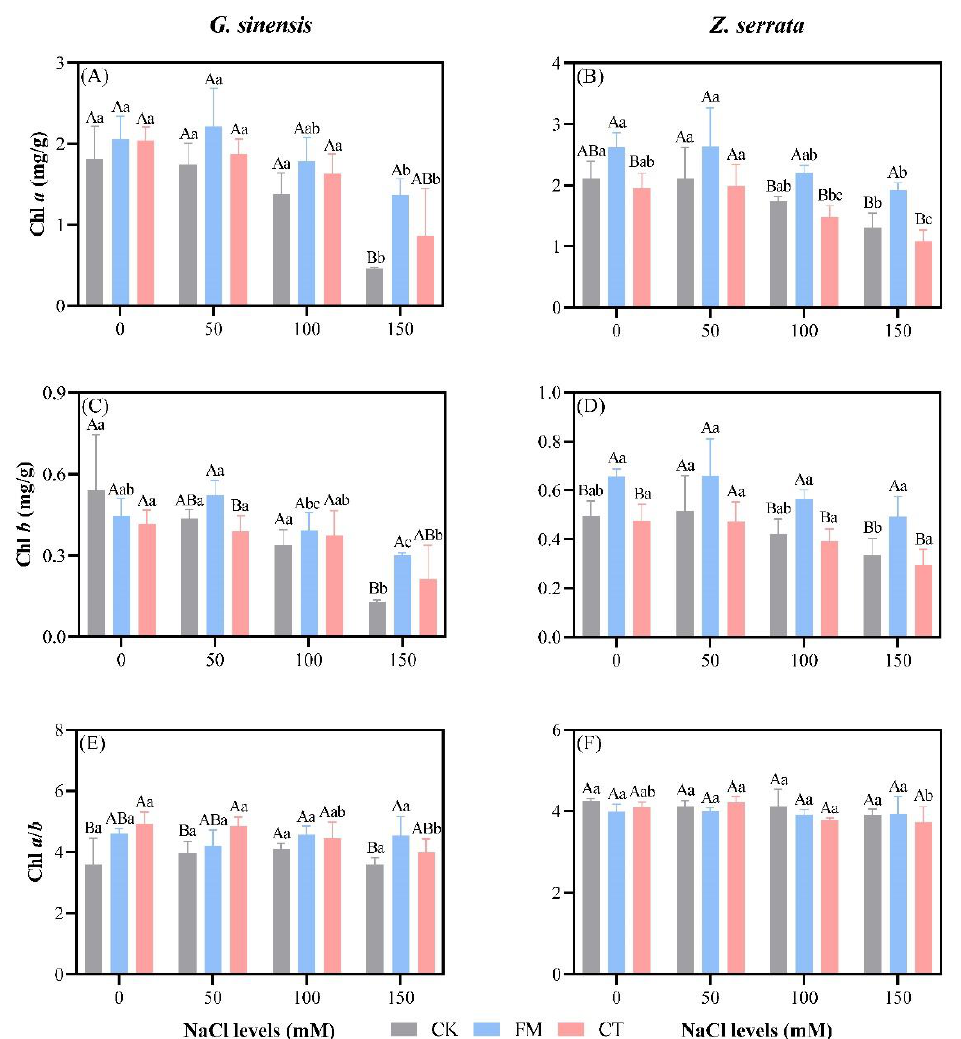
Figure 4. Variation in the chlorophyll a and b content and ratio of chlorophyll a to chlorophyll b content between treatments. ( A ) chlorophyll a content of G. sinensis different treatments; ( B ) chlorophyll a content of Z. serrata different treatments; ( C ) chlorophyll b content of G. sinensis different treatments; ( D ) chlorophyll b content of Z. serrata different treatments; ( E ) ratio of chlorophyll a content to chlorophyll b content of G. sinensis different treatments; ( F ) ratio of chlorophyll a content to chlorophyll b content of Z. serrata different treatments. Uppercase letters indicate A significant difference between various inoculation treatments under the same salt levels ( p < 0.05). Lowercase letters indicate a significant difference between various salt concentrations under the inoculation treatments ( p < 0.05).